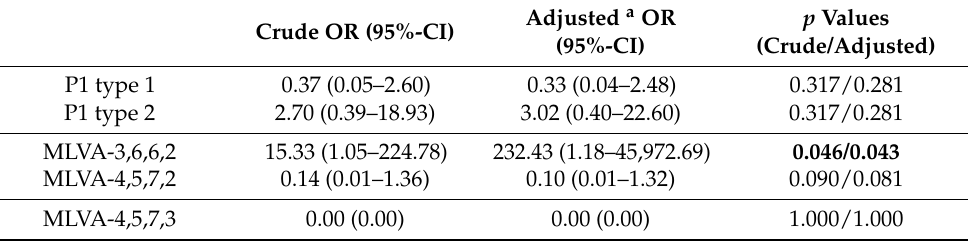
Table 6. Logistic regression analysis of hospital admission of Mycoplasma-pneumoniae -infected patients because of cutaneous disease. Significant differences ( p < 0.05) are highlighted in